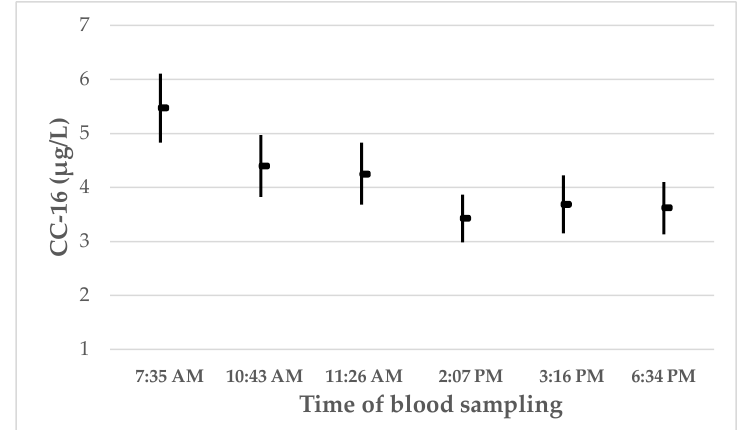
Figure 2. The arithmetic mean (and 95% CI) concentrations of CC-16 in serum according to time of blood sampling. The mean (and min/max) sampling times were: 7:35 AM † (5:55 AM/9:39 AM); 10:43 AM † (9:45 AM/0:09 PM); 11:26 AM ¶ (10:03 AM/2:03 PM); 2:07 PM † (0:11 PM/9:47 PM); 3:16 PM ¶ (2:10 PM/5:02 PM); and 6:34 PM ¶ (5:06 PM/10:19 PM). † Baseline. ¶ Follow-up.